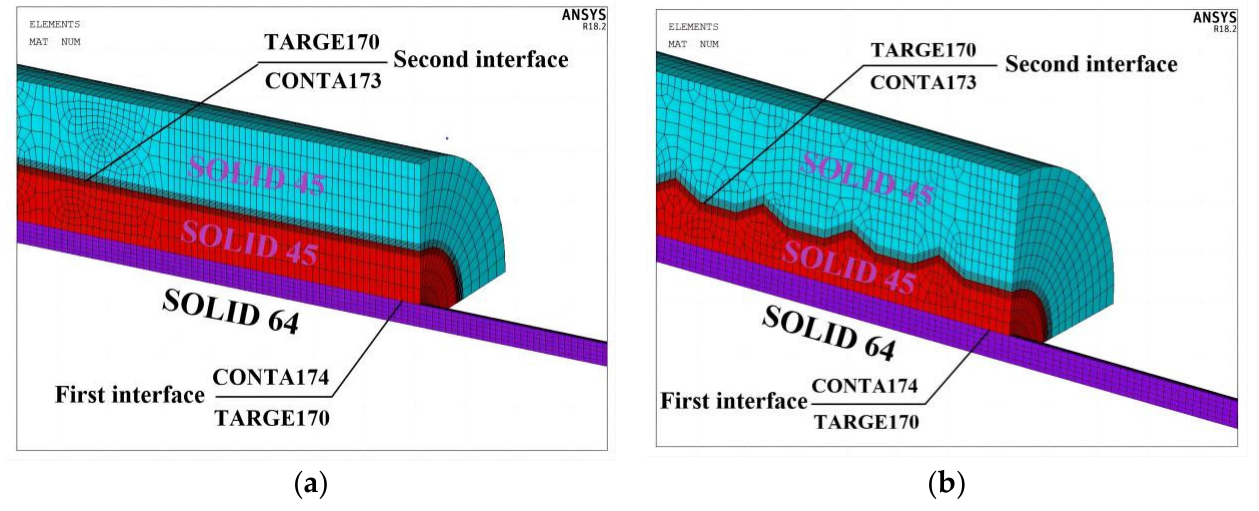
Figure 6. FE model: ( a ) anchorage system without groove; ( b ) anchorage system with groove.